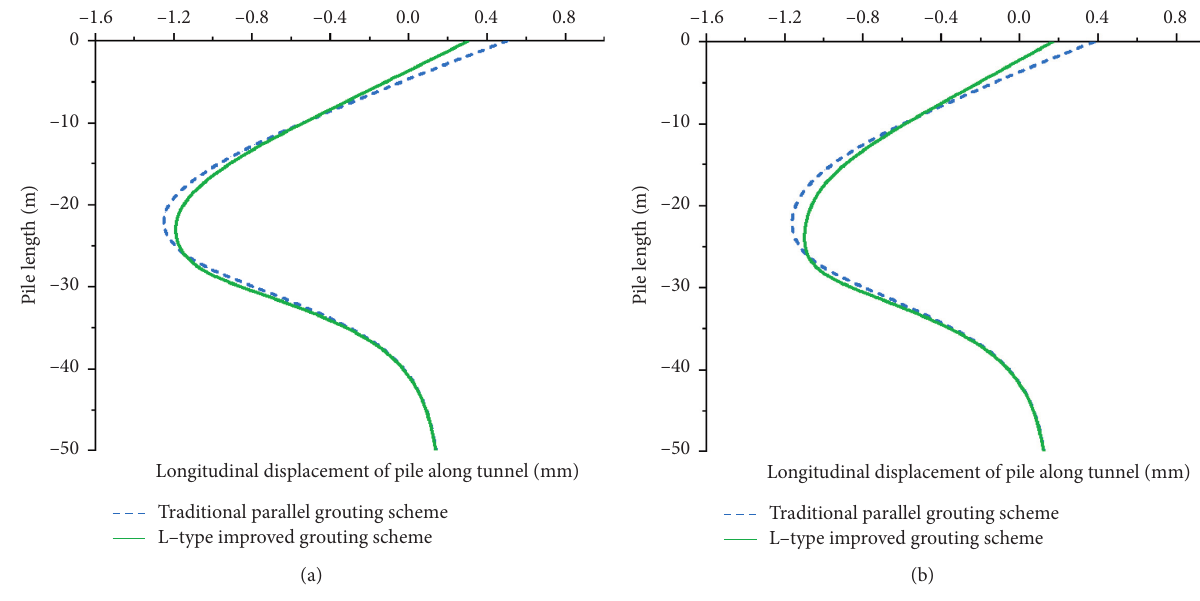
Figure 23: Longitudinal displacement of the pile along tunnel: (a) 2 rings after passing the pile; (b) 4 rings after passing the pile.